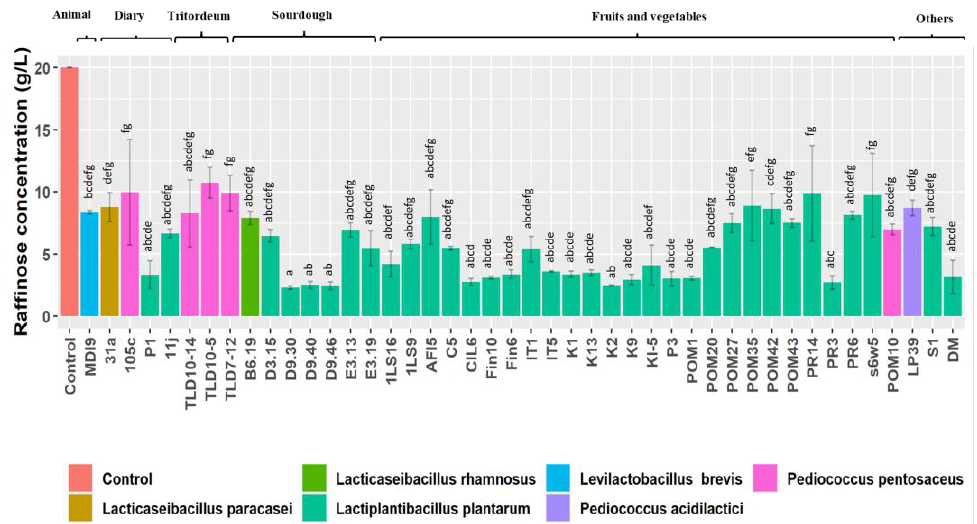
Figure 2. Residual raffinose concentration (g/L) of 44 high-resistant lactic acid bacteria strains, belonging to different species and isolated from different sources, after incubation of Raf-MRS (MRS broth medium supplemented with 20 g/L of raffinose) at 30 °C for 24 h. Data are expressed as the mean of three separate analyses ± standard deviations. Bars with different superscript letters differ significantly ( p < 0.05).